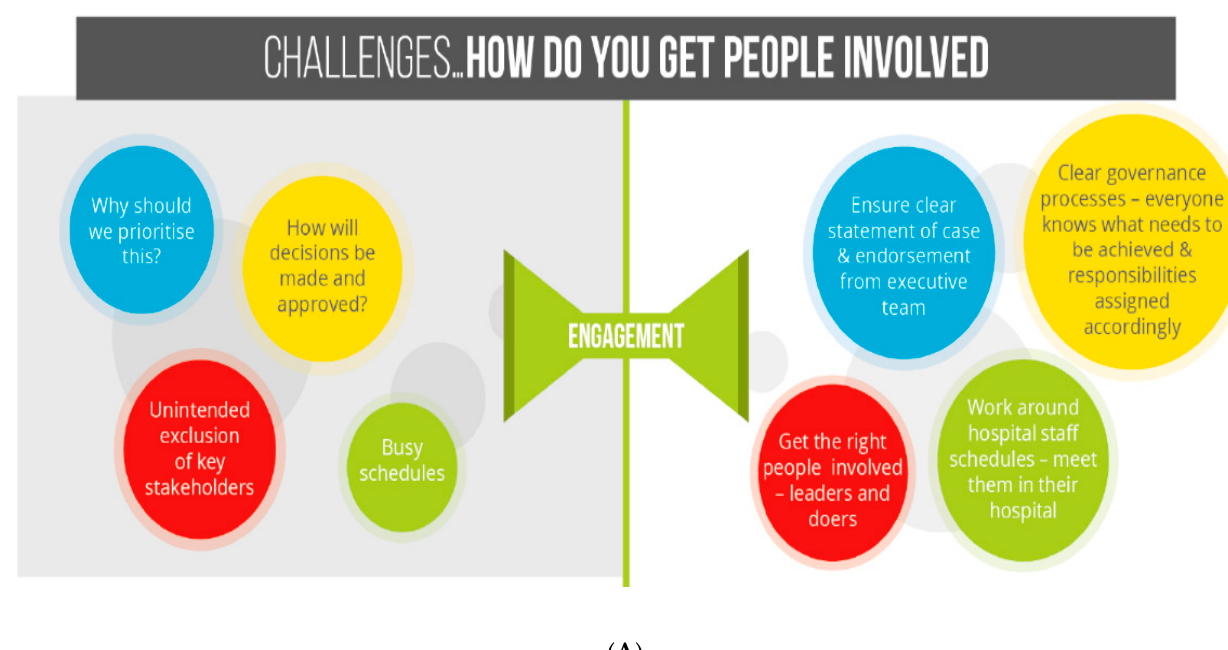
Figure 3. The pillars of success of the CURE Project.